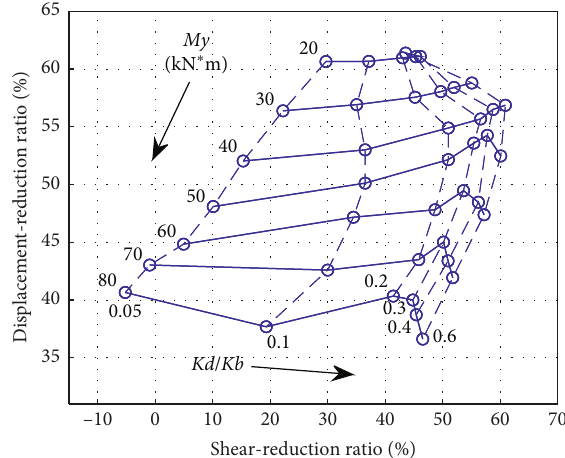
Figure 21: Curve of seismic reduction performance affected by bending direction